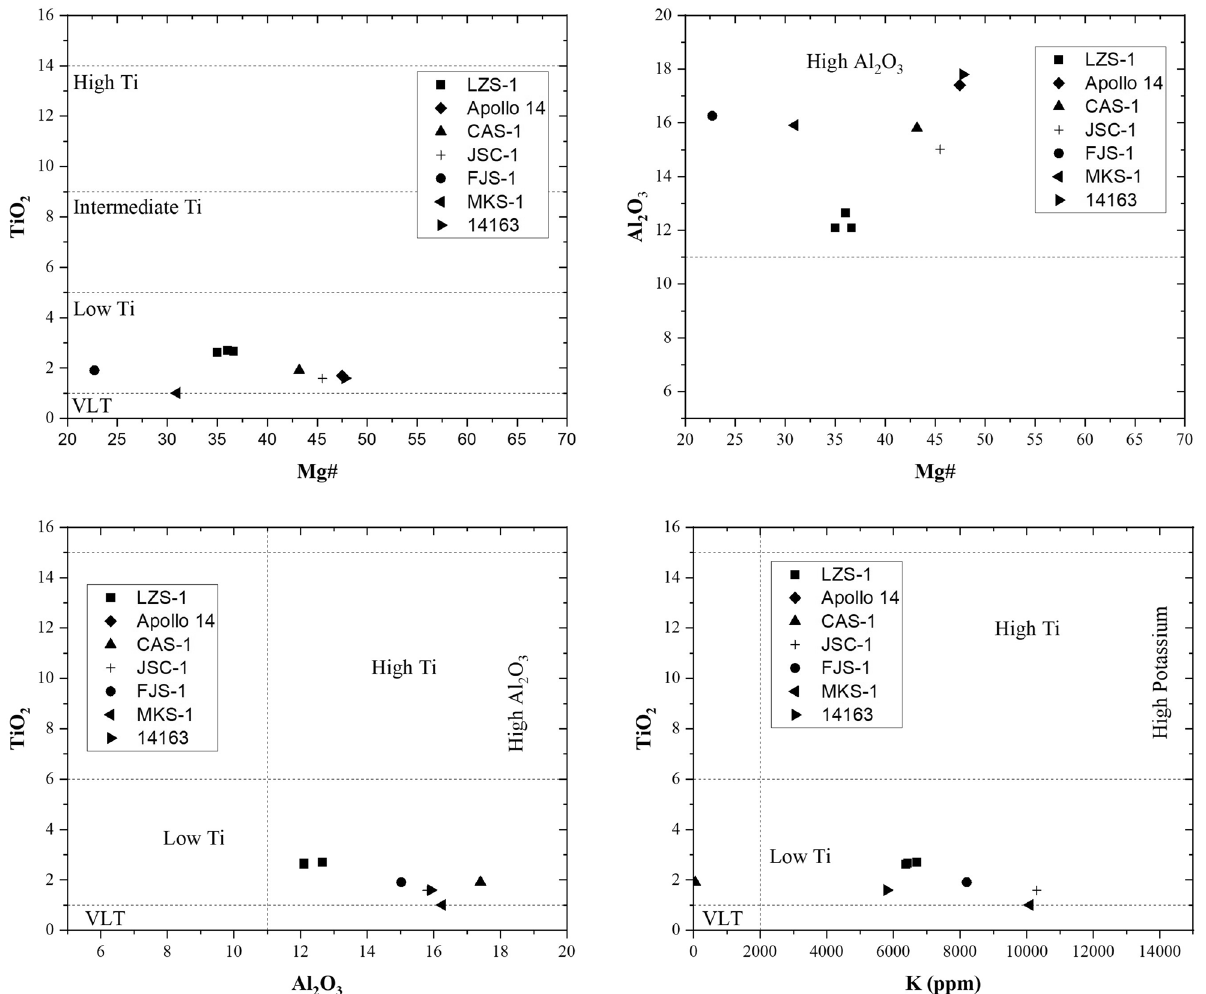
Figure 2. Classification diagrams of the lunar regolithic simulants and samples of LZS-1, Apollo 14, CAS-1, JSC-1, FJS-1, MKS-1 and 14,163 (Zheng et al. 5 ) according to their content in Mg # (Mg / Mg + Fe) TiO 2 , Al 2 O 3 and K (ppm).